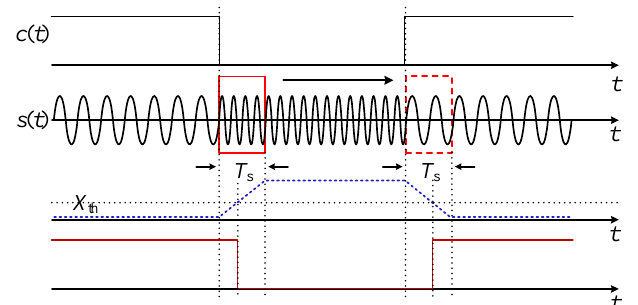
Figure 15. The demodulation process.